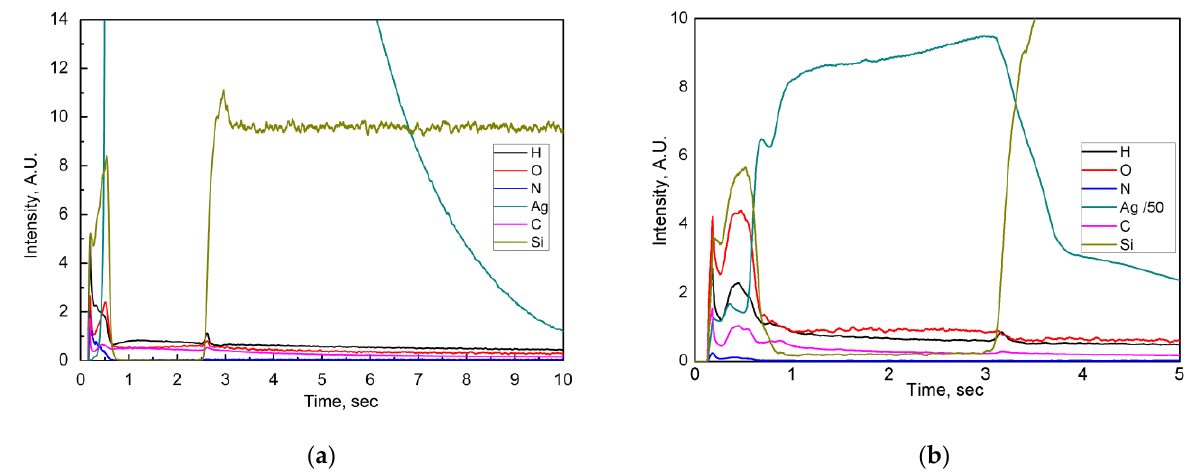
Figure 9. GD-OES profiles of the elements in a SiN x /Ag mirror with a 4.5 nm SiN x protection treated with O 2 plasma for ( a ) 1 min and ( b ) 40 min.